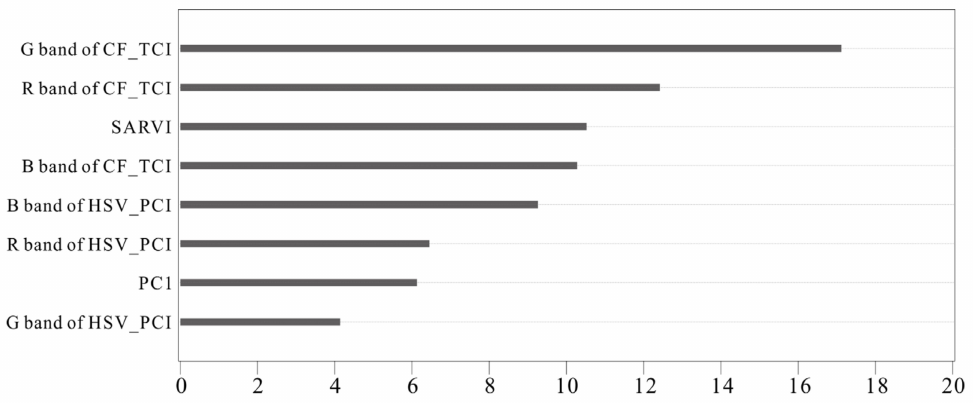
Figure 7. Contribution ranking of each classification factor to the RF-based classifier.